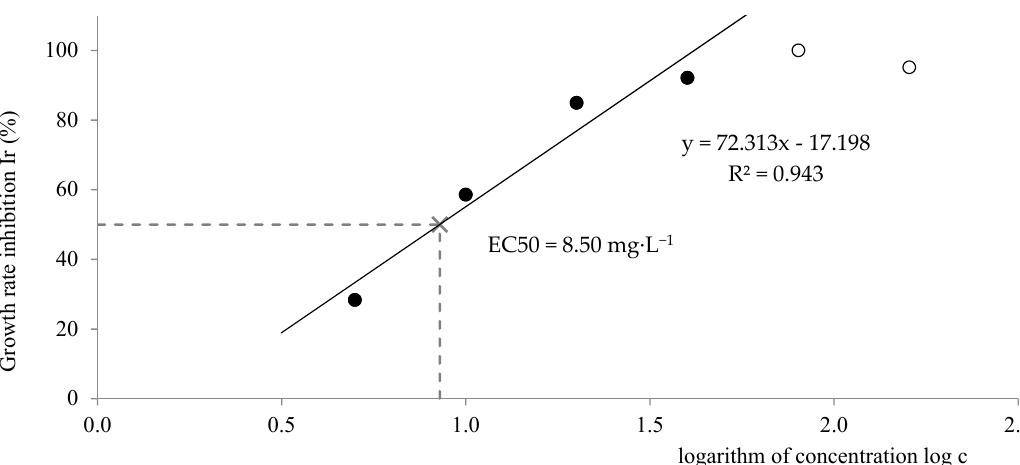
Figure 9. Graphical results of the test on the Lemna minor from the counted number of leaves.